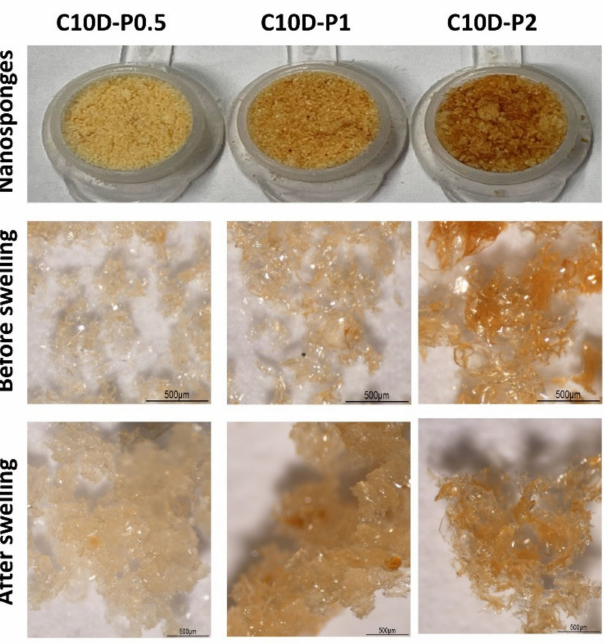
Figure 2. Physical appearance of nanosponges before and after swelling in water. For the systems without cyclodextrin, C10-P0.5, C10-P1, and C10-P2, the